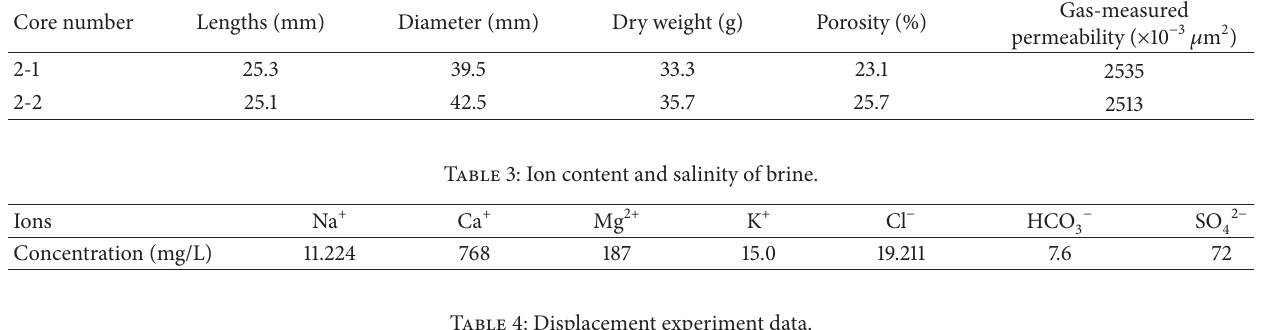
Table 4: Displacement experiment data.